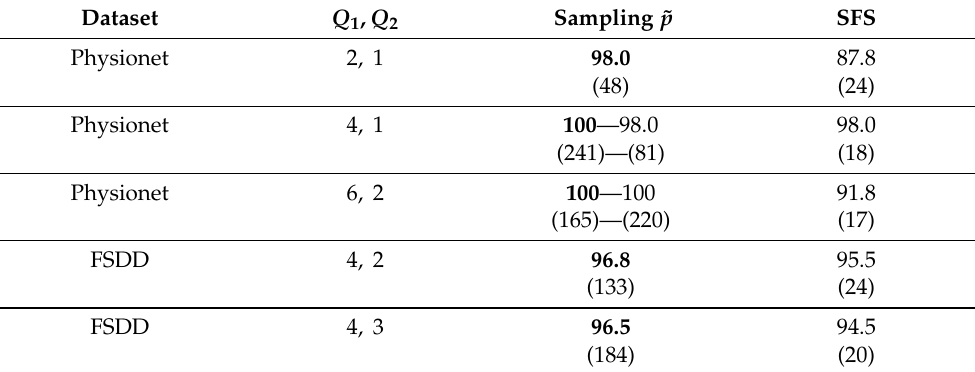
Table 4. 1st col: Dataset; 2nd col: WST Q factors; 3rd col: Classification accuracy (%) for the